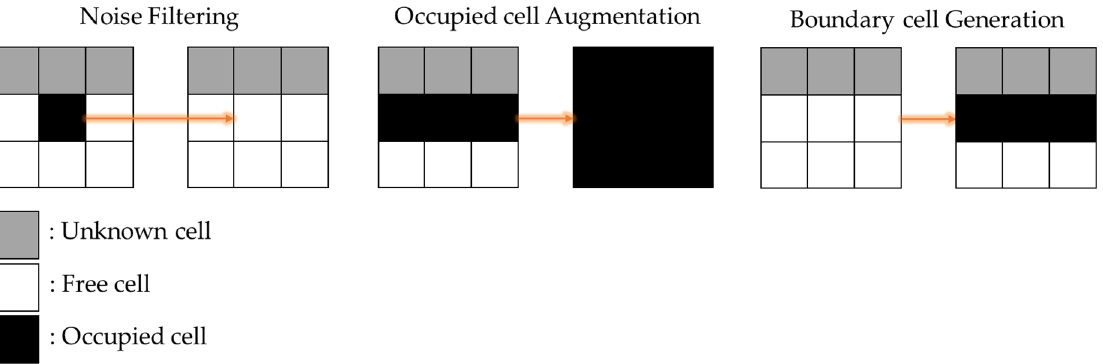
Figure 2. Map pre-processing (including noise filtering, occupied cell augmentation, and boundary cell generation).